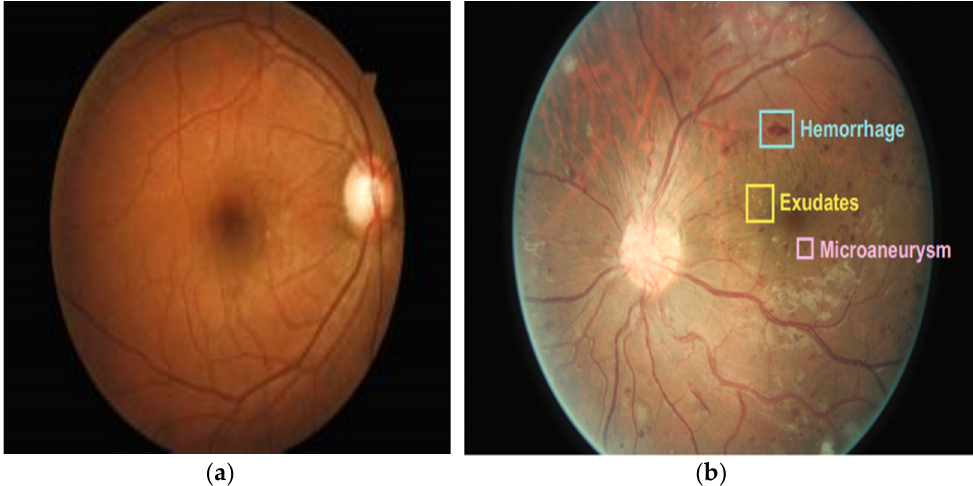
Figure 1. ( a ) Eye structure of Non-DR patient; ( b ) Eye structure of DR